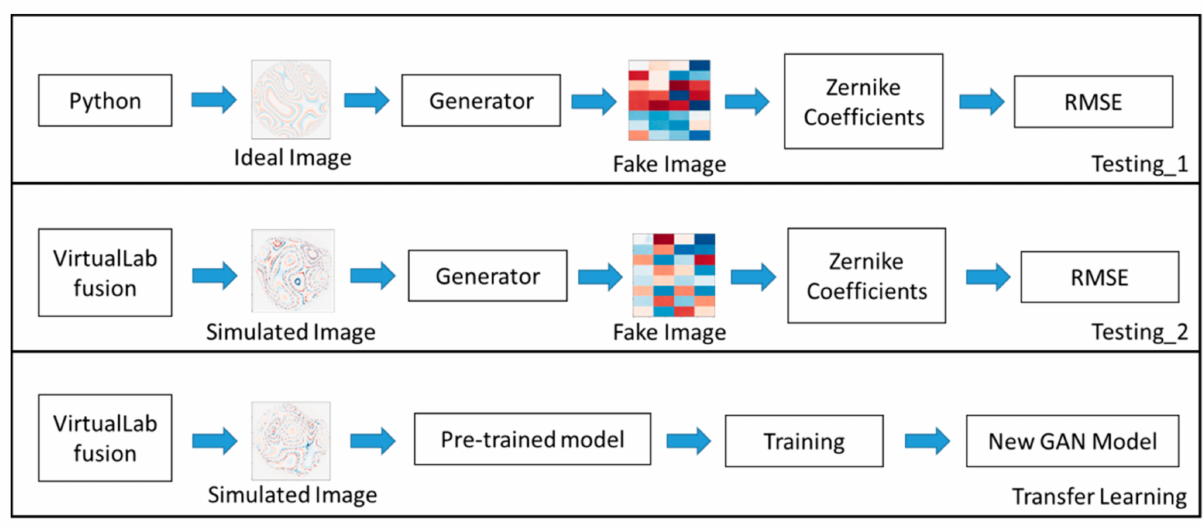
Figure 5. The flowchart of the testing and transfer